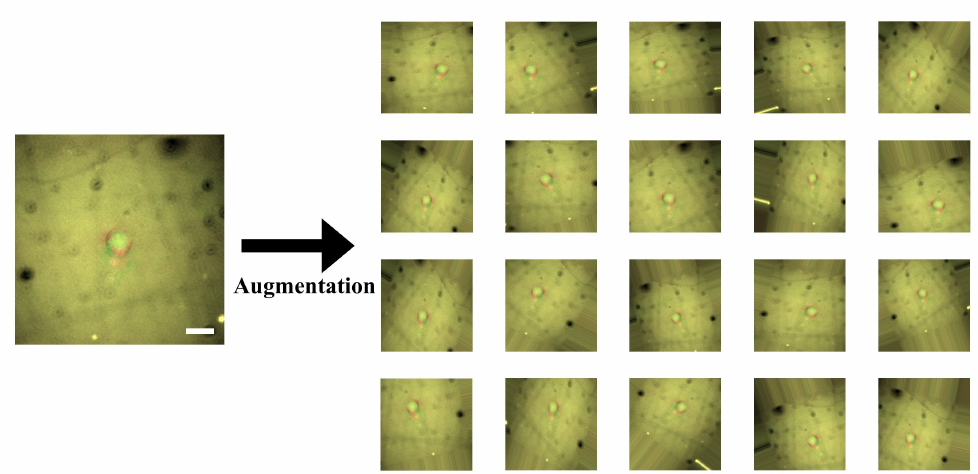
Figure 6. Data augmentation for combined cell images. We have only a relatively small-scaled dataset. Scales and resolutions of the images cannot be constant in reality. To make our convolutional neural network (CNN) model robust to this issue, we augmented the images by the parallel translation, rotational translation, scale adjustment, etc. Scale bars indicate 20 µ m.